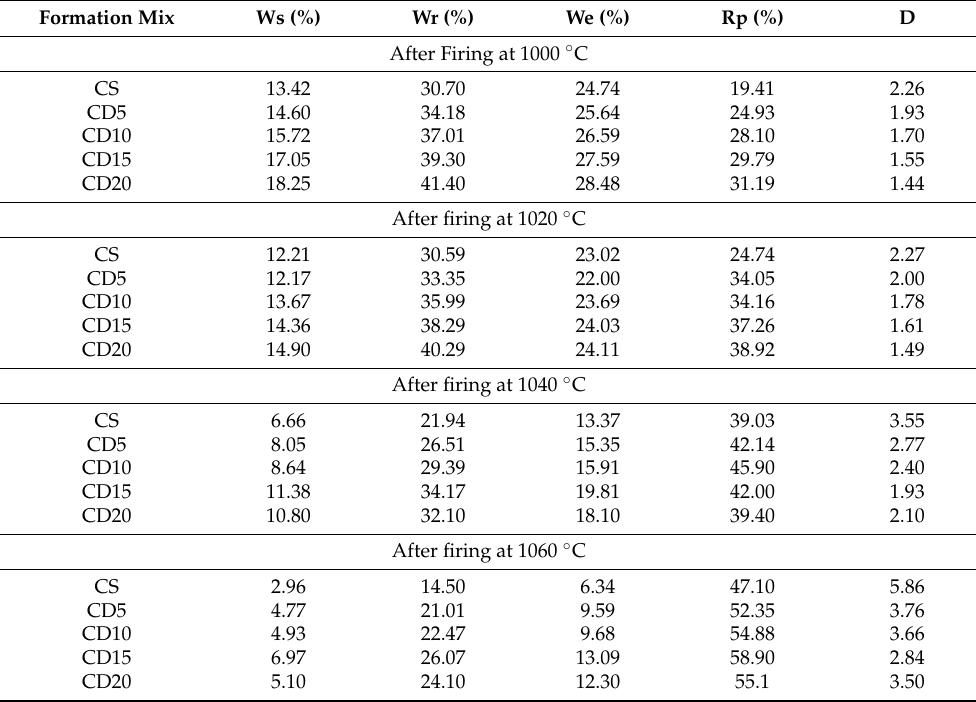
Table 5. Water absorption, apparent porosity, and calculated structural parameters of ceramic